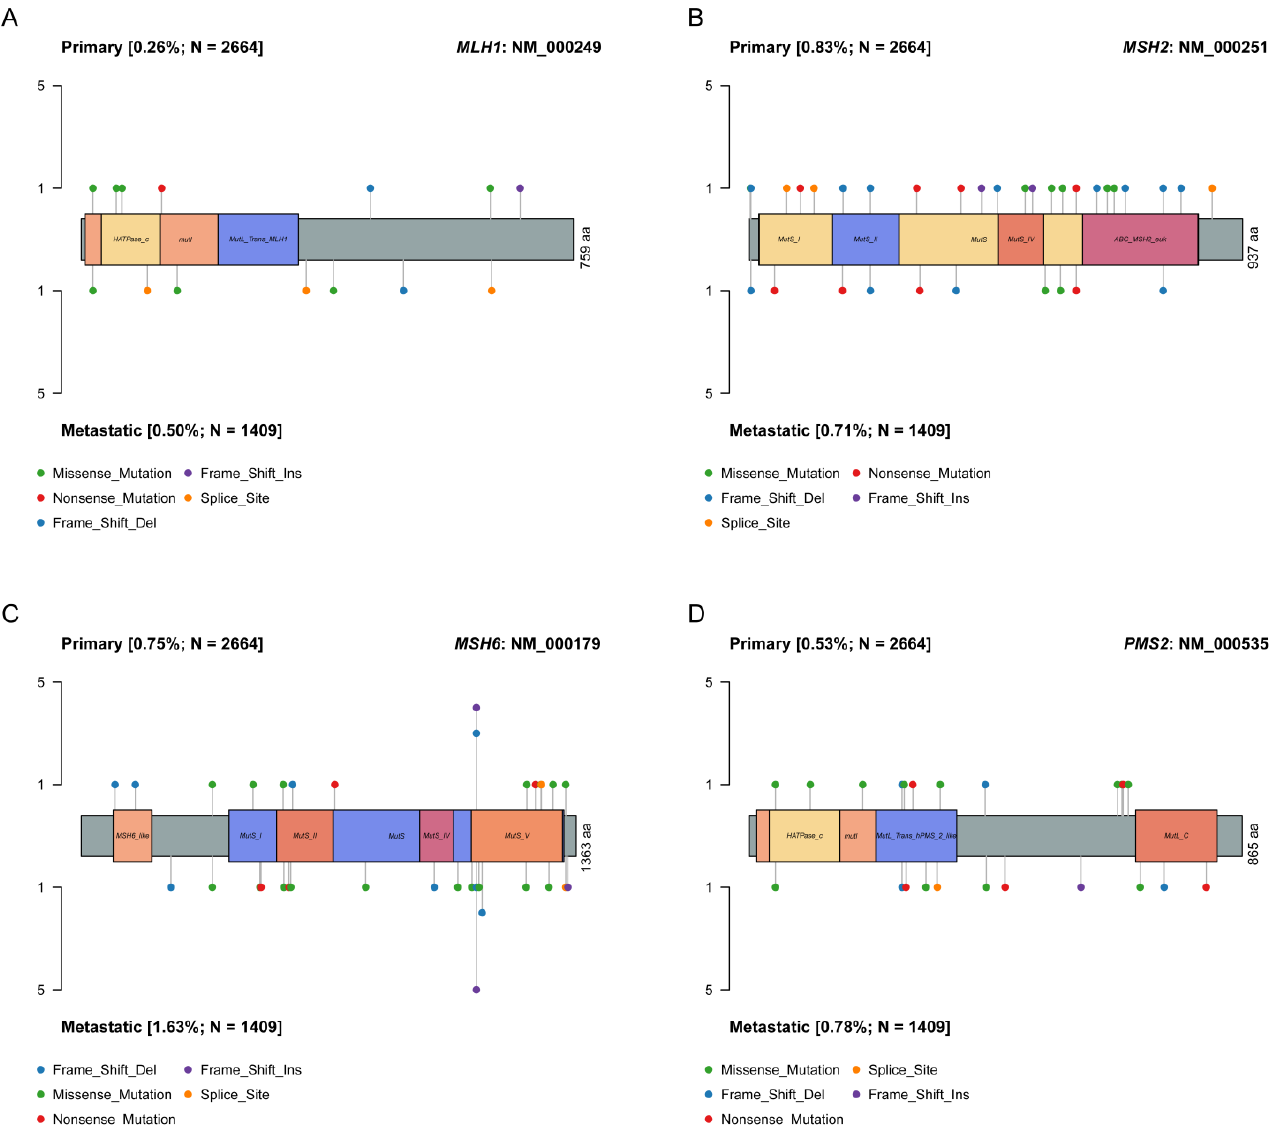
Figure 2. Locations of pathogenic mutations in MMR genes. Lollipop plots showing ( A ) pathogenic mutations of MLH1 , ( B ) pathogenic mutations of MSH2 , ( C ) pathogenic mutations of MSH6 and ( D ) pathogenic mutations of PMS2 . The mutations in primary tumors are displayed above the lollipop, and the mutations in metastatic tumors are displayed below the lollipop. aa = amino acid; Del = deletion; Ins = insertion.